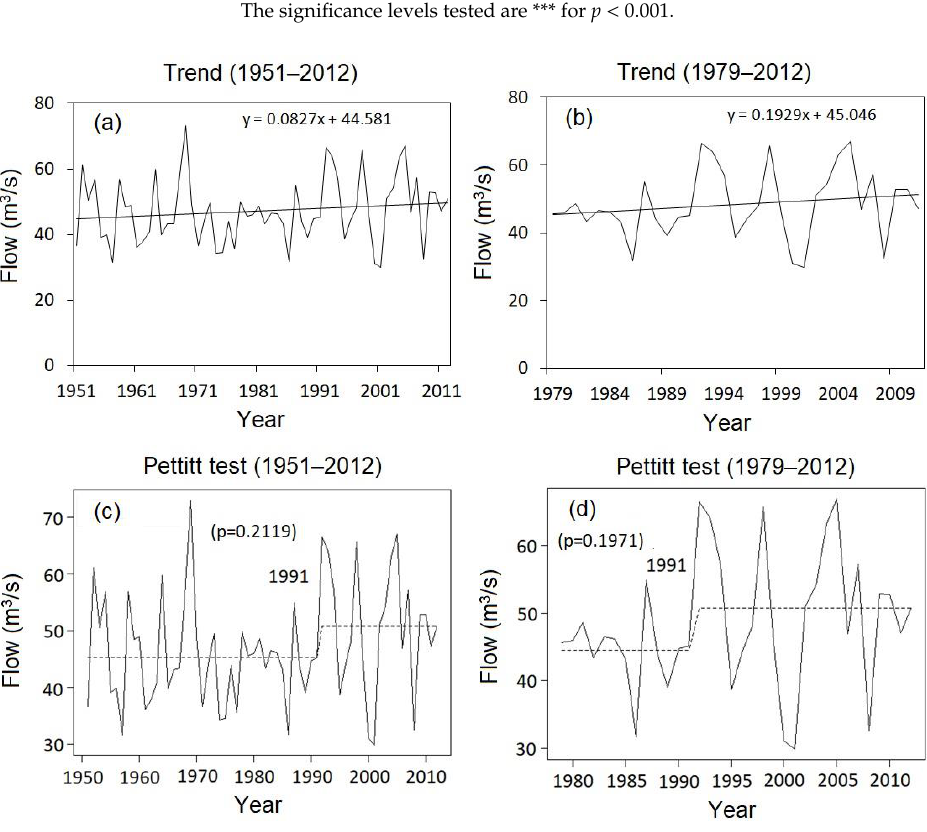
Figure 8. The annual flow trends during the ( a ) 1951–2012 and ( b ) 1979–2012 periods and the Pettitt’s test during the ( c ) 1951–2012 and ( d ) 1979–2012 periods at the Dahana discharge gauging station in the upstream region of the Kofarnihon River Basin.